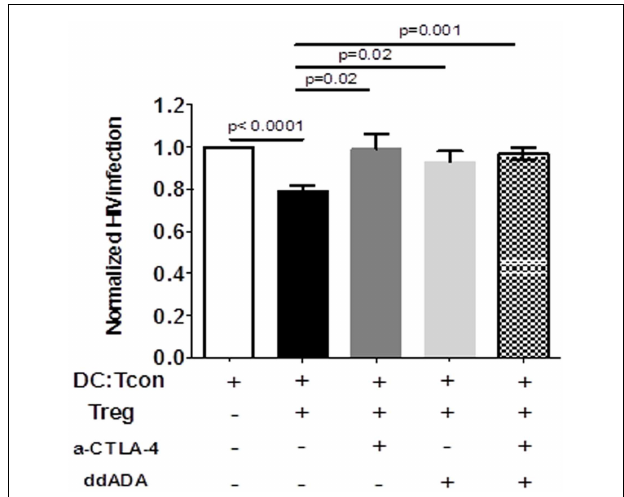
FIGURE 6 | RegulatoryT cells-mediated suppression of viral infection is mediated by their CTLA-4 or cAMP activity . DC:Tcon:Treg were co-cultured for 24h in the presence or not of anti-CTLA-4 blocking antibody. Treg previously treated with an inhibitor of adenyl cyclase (ddADA) were added or not to DC:Tcon co-cultures. Percentage of HIV-infectedTcon in clusters was normalized based on corresponding cultures withoutTreg. Effect of individual CTLA-4 or cAMP and combined CTLA-4/cAMP blockade are shown. Mean and SE are shown ( n = 12).